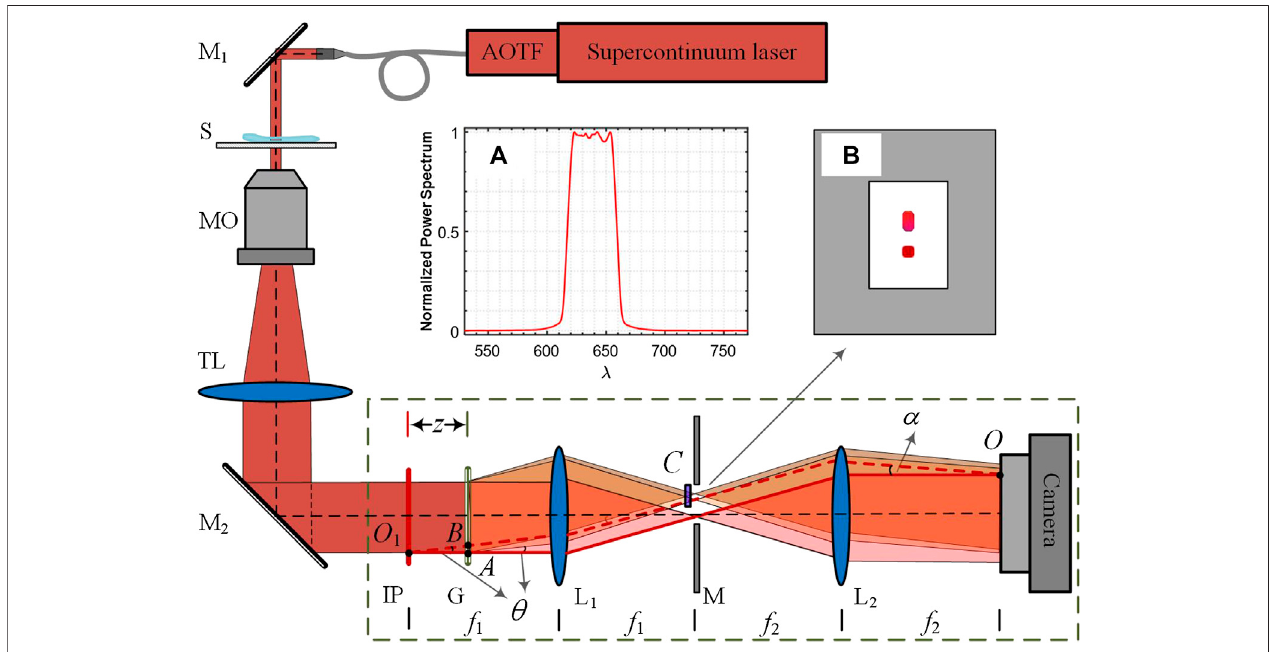
FIGURE1| AninvertedmicroscopewiththeLC-SICAmodule(markedbydashedrectangle),connectedtoitsoutput. M 1 , M 2 ,mirrors;S,sample;MO,microscope objective;TL,tubelens;IP,imageplane; G,diffractiongrating(100 lines/mm); L 1 , L 2 ,lenses withfocallengthsof f 1 (cid:1) 150 mmand f 2 (cid:1) 300 mm; z ,distance ofIPtoG;M, mask that selects only two diffraction orders; C, compensating plate; α , interference angle; θ , diffraction angle ofthe grating. Inset (A) normalized power spectrumofthe light source with central wavelength of 638 nm and bandwidth of 44 nm. Inset (B) schematic of the fi ltered Fourier spectrum distribution in the focal plane.